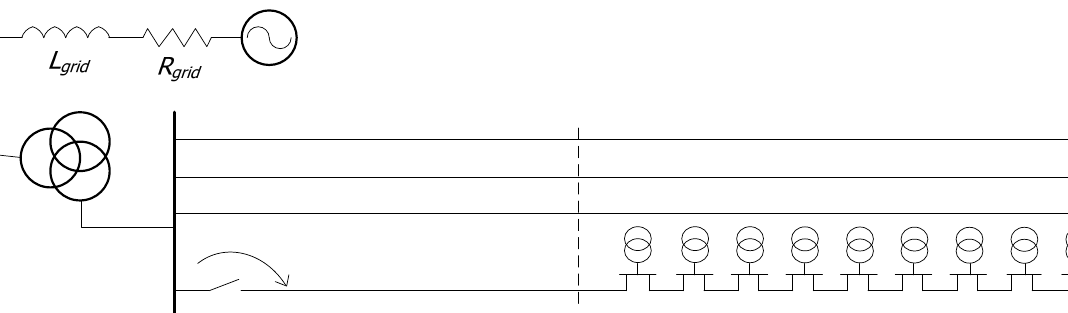
Figure 2. Schematic of network model where only radial A is modelled in